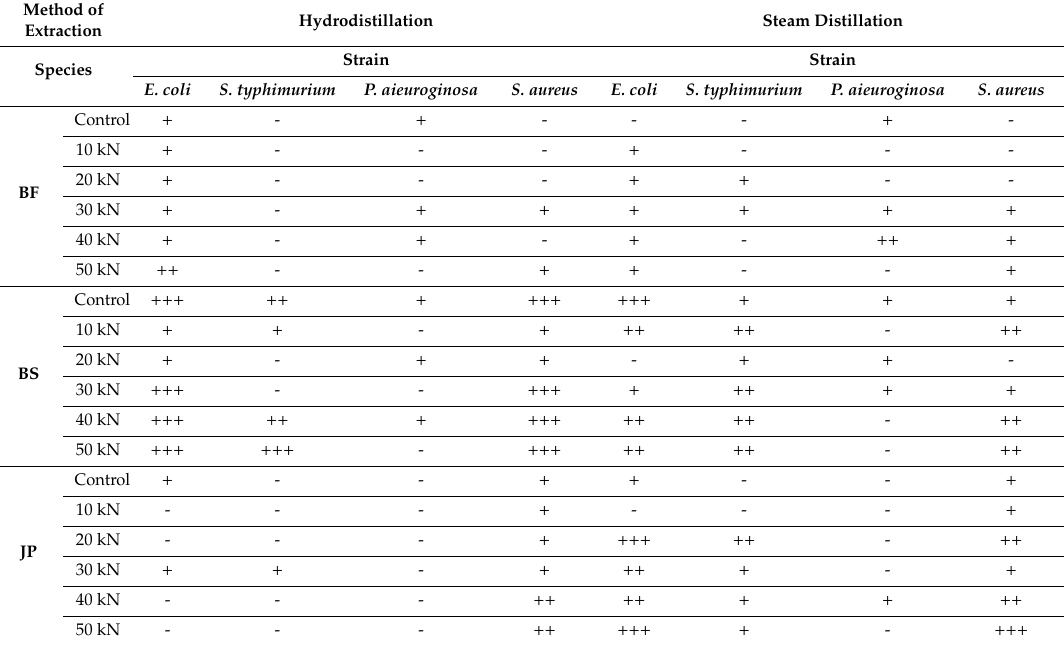
Table 4. Inhibition diameters of S. aureus , E. coli , P. aieuroginosa, and S. typhymurium against the EOs of BF, BS, and